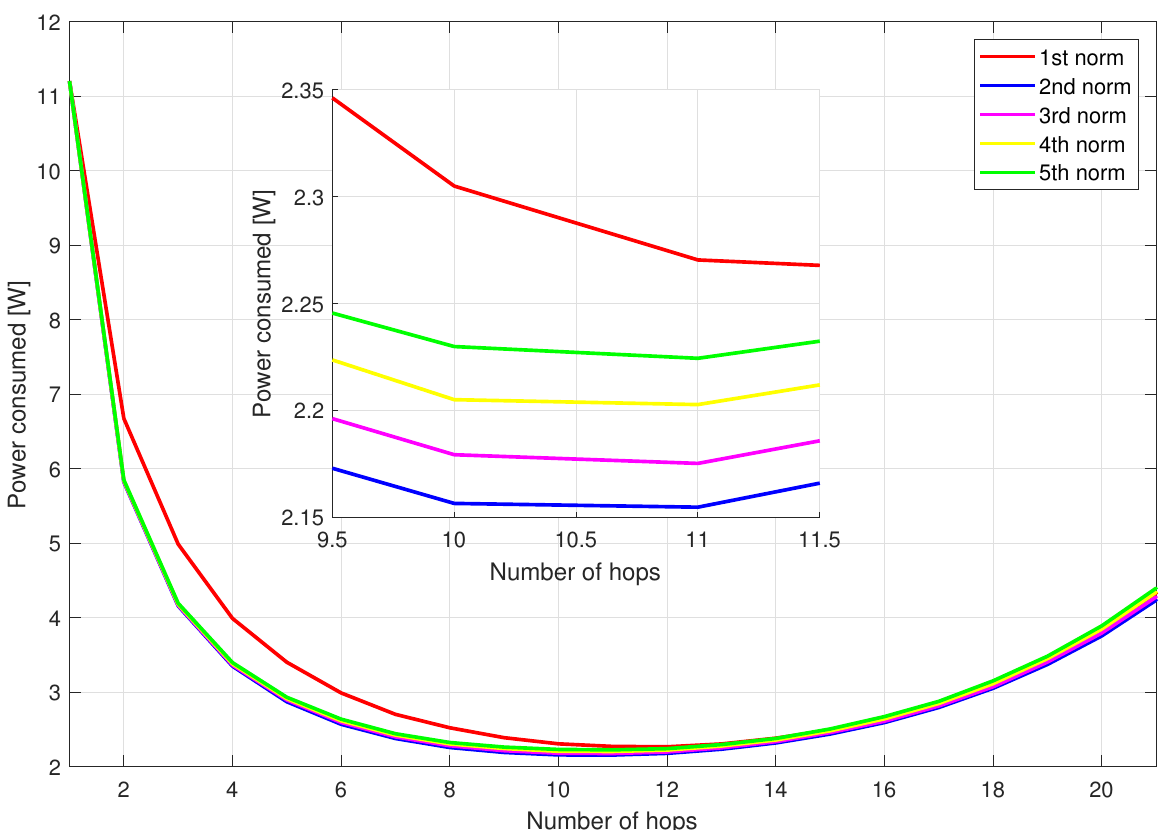
Figure 5. Power consumption of the network with 30 relays for area width of 5